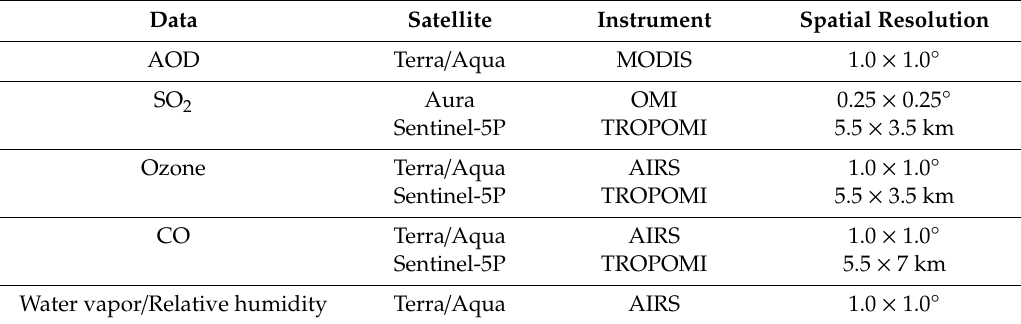
Table 1. Details of satellite data used in this